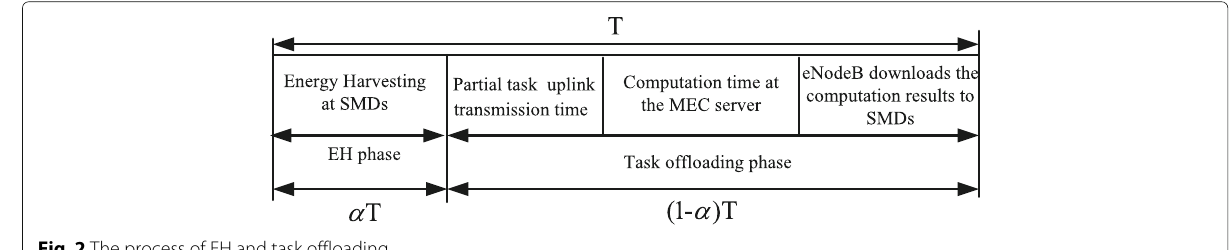
Fig. 2 The process of EH and task